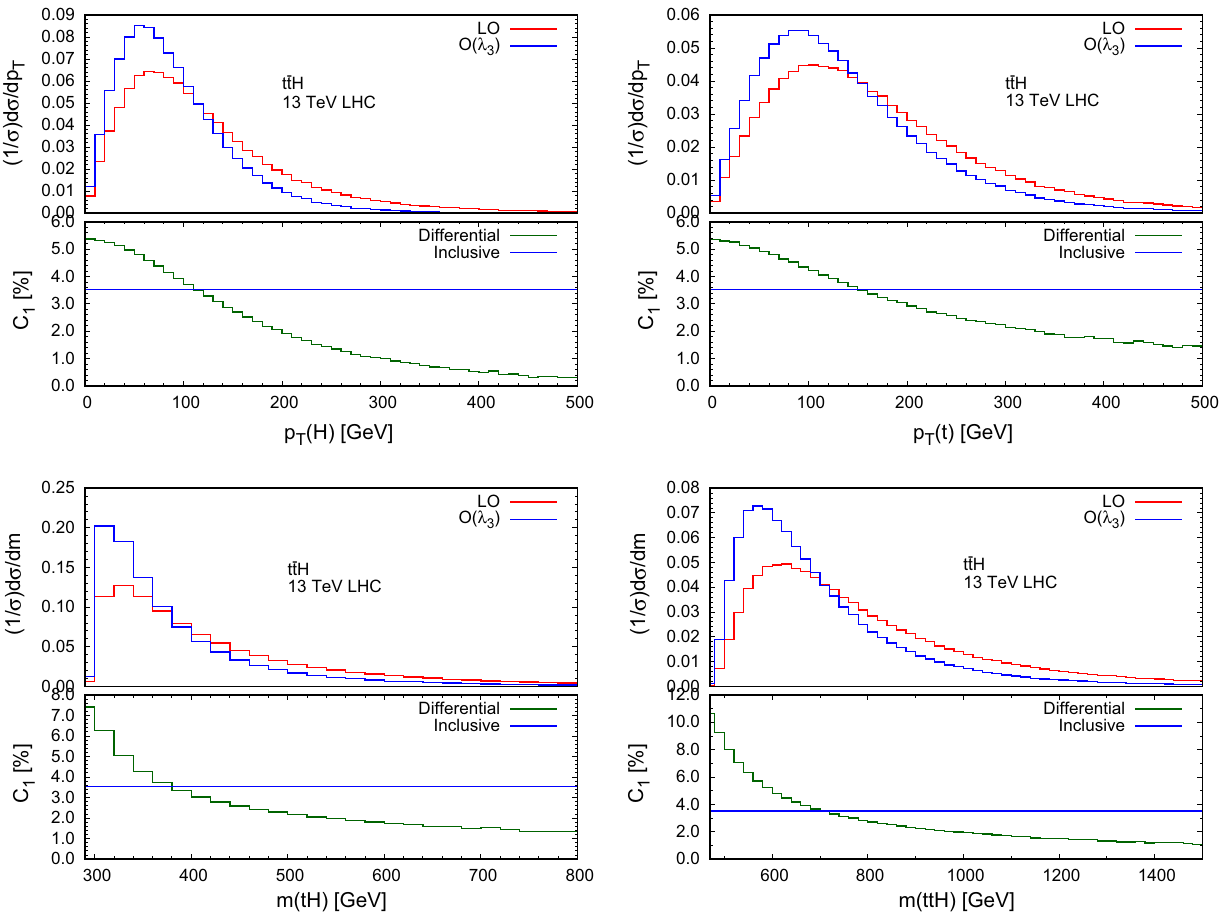
Fig. 5 Effect of O (λ 3 ) correction in t ¯ tH at 13 TeV LHC. Upper panel: normalized distributions at LO (red) and at O (λ 3 ) (blue). Lower panel: C 1 at the differential (green) and inclusive (blue)